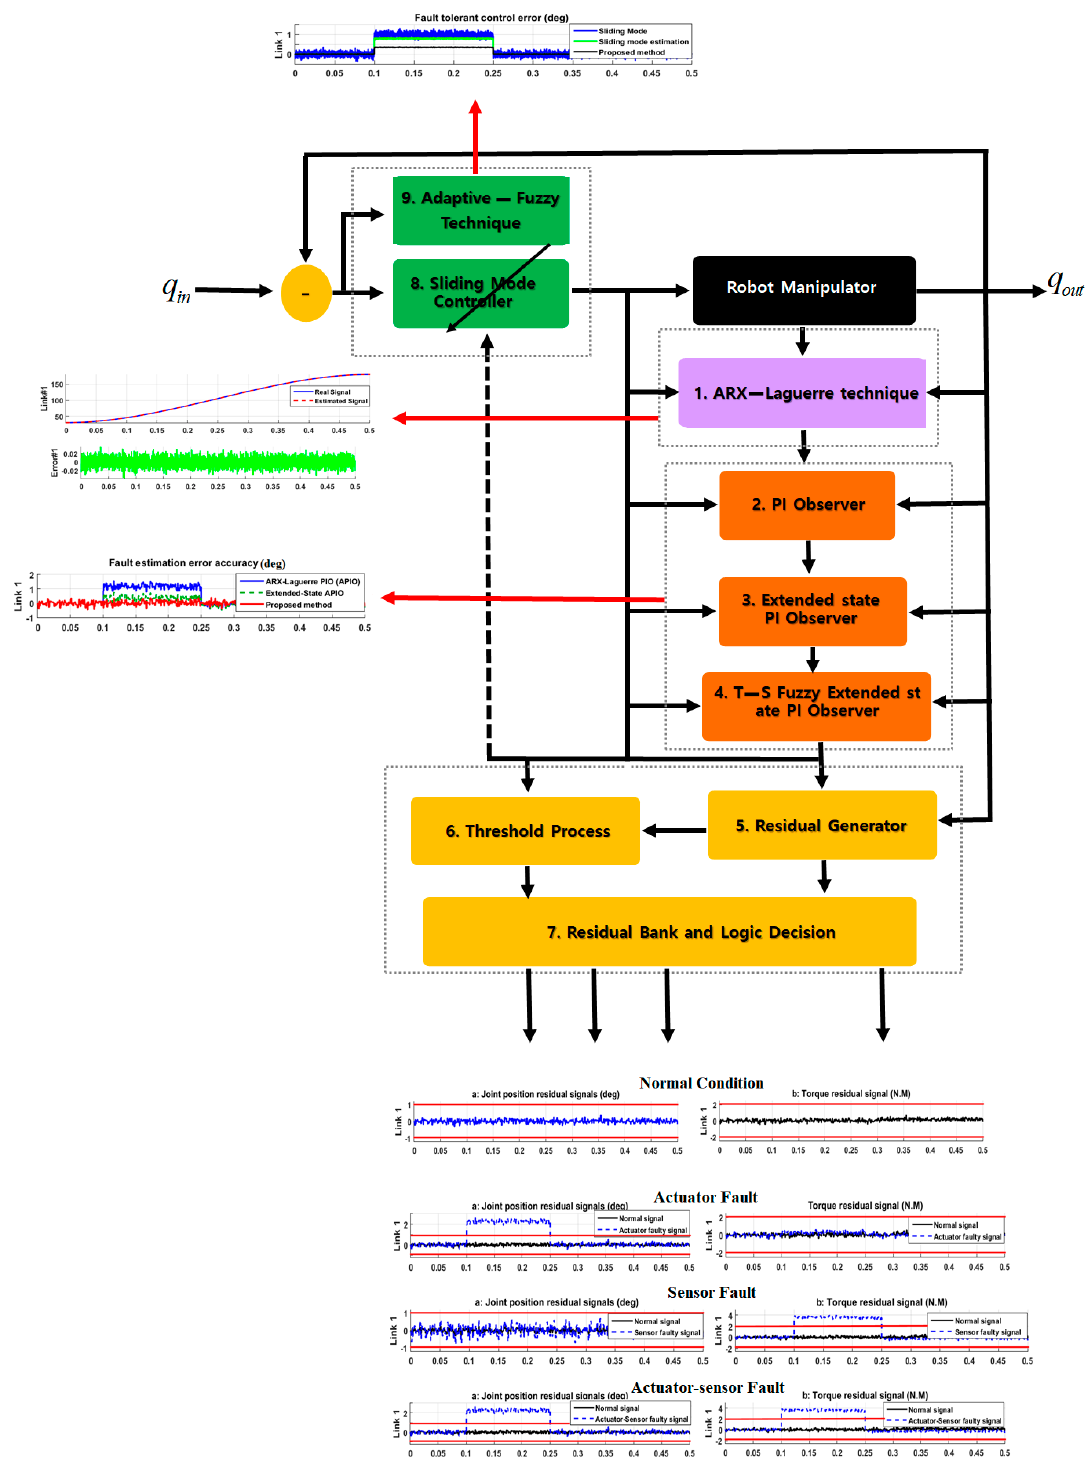
Figure 8. Block diagram of the proposed technique for fault diagnosis and fault-tolerant control.